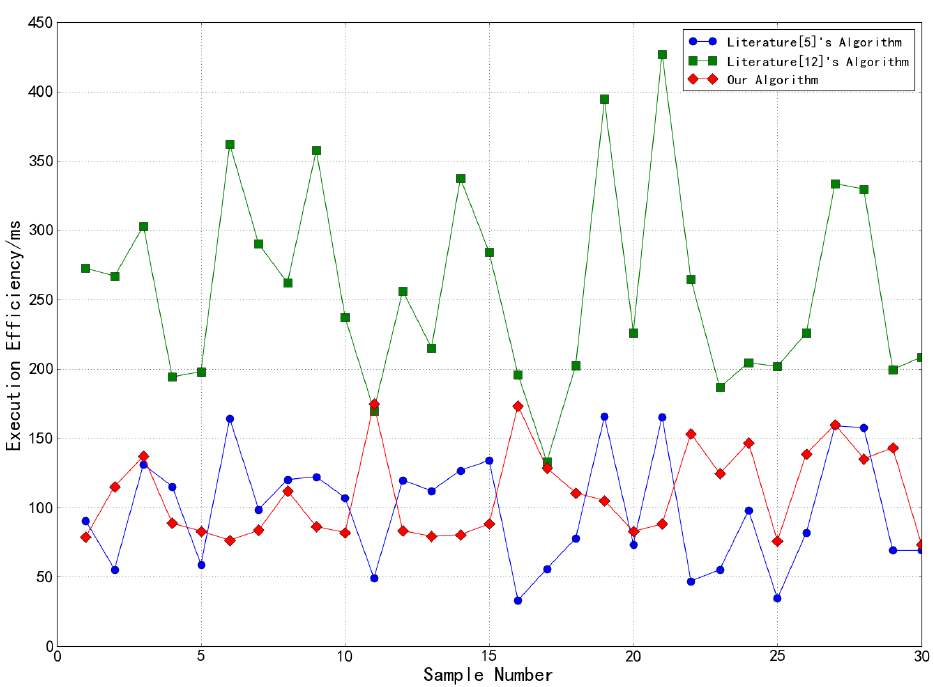
Figure 20. Algorithms execution efficiency comparison